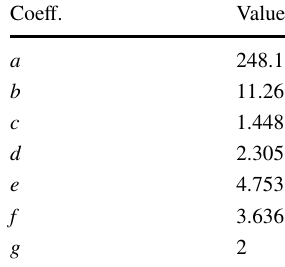
Fig. 2 Mutation process in GP Fig. 3 Tree structure of new correlation